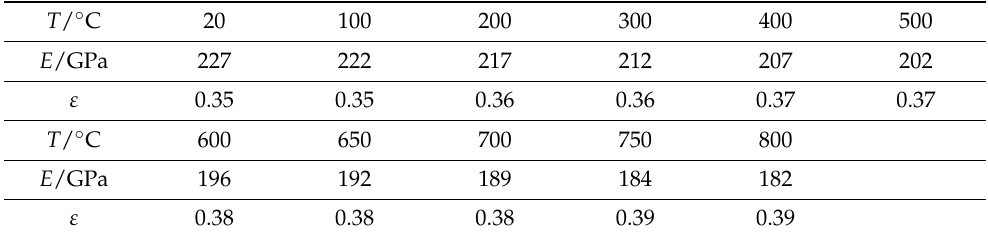
Table A5. Elastic modulus ( E ) and Poisson’s ratio ( ε ) of rotational solid material. T / ◦ C